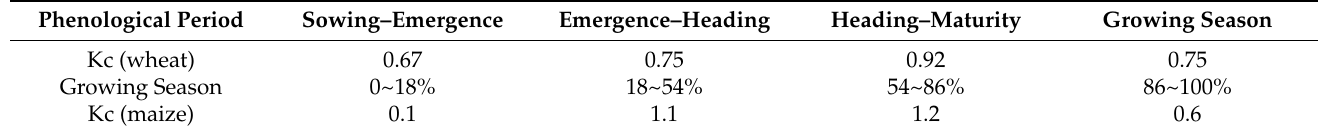
Table 3. Values of Kc for wheat and